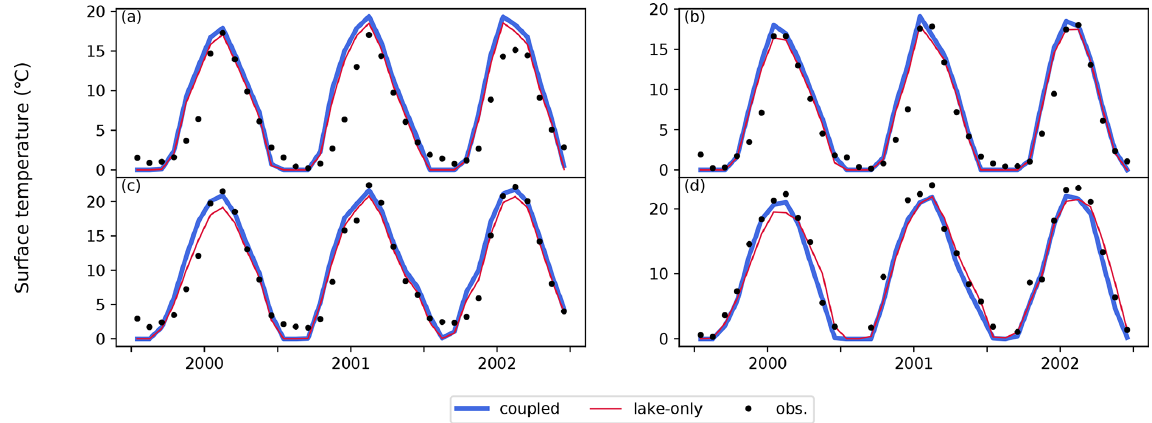
Figure 11. Time series of monthly mean values of river temperature ( ◦ C) for (a) Lake Superior, (b) Lake Ladoga, (c) Lake Ontario, and (d) Lake St. Clair (HydroLAKES ID 5, 10, 7, and 66, respectively). Black dots show the observed values, and blue (red) lines show the calculated values from the coupled (lake-only)